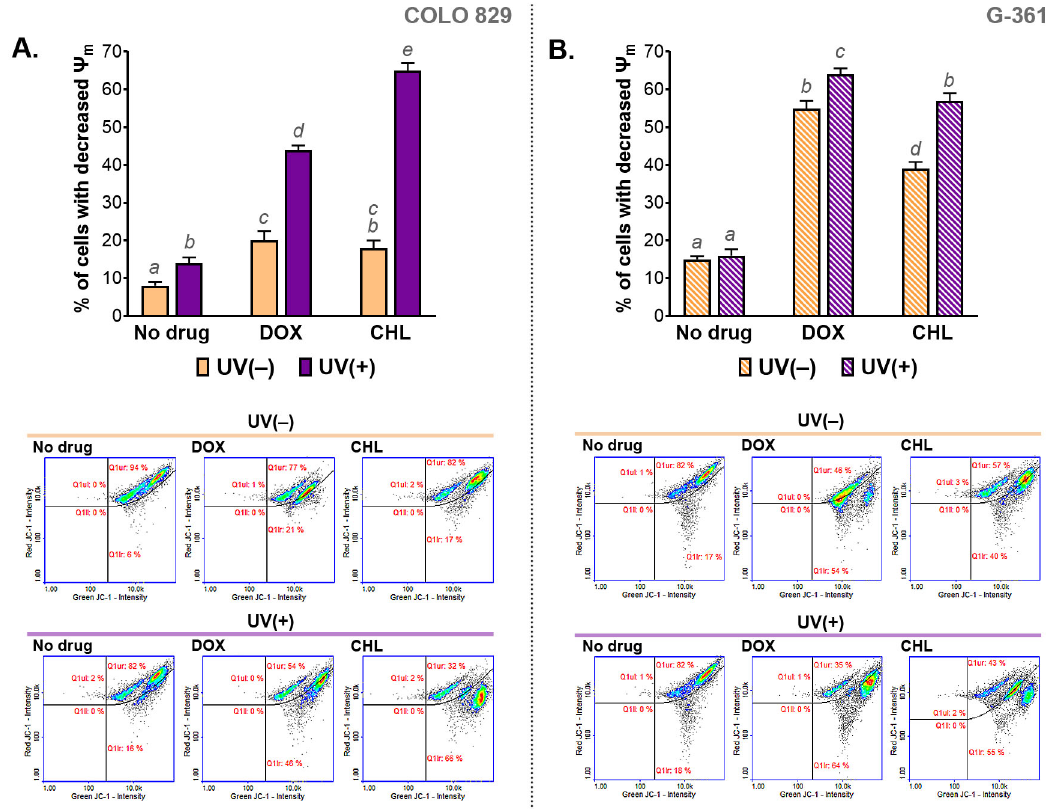
Figure 4. The analysis of the mitochondrial membrane potential ( ψ m) in melanoma cells COLO 829 ( A ) and G-361 ( B ) incubated with doxycycline and chlortetracycline and exposed to UVA radiation. Mean values ± SD were presented in bar graphs. Sample scatter plots show representative results for the analysis of the tested cell populations. Using different letters to show statistical